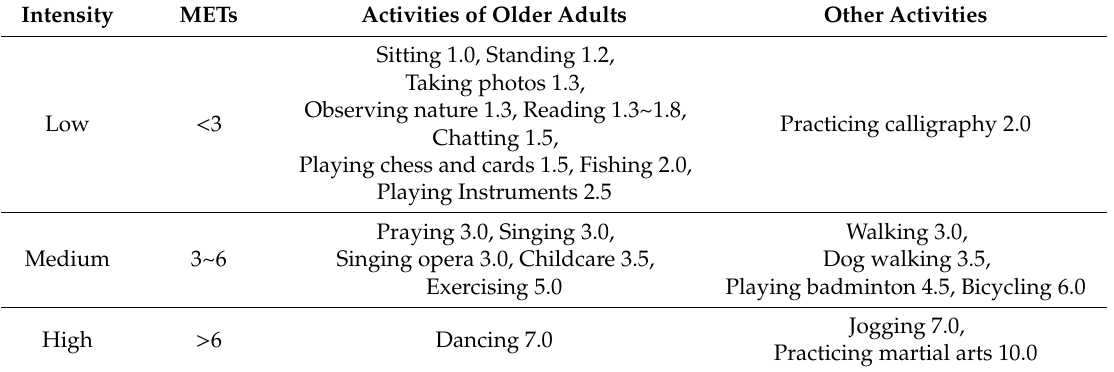
Table 2. METs value of select amenity building